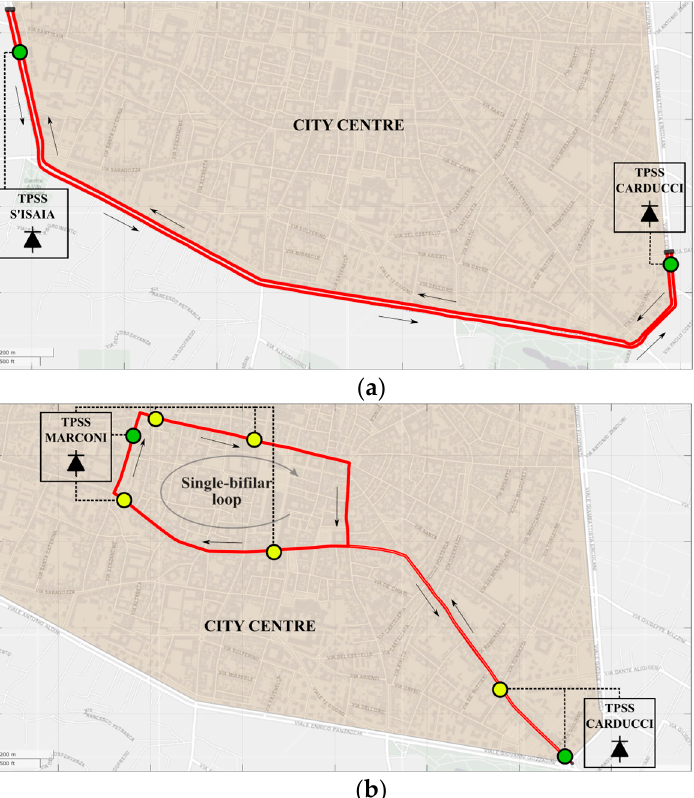
Figure 7. Bologna’s FSs selected for the case study. The trolleybus routes (oriented by arrows) of the FS “S’Isaia-Carducci” ( a ) and FS “Marconi-Carducci” ( b ) are plotted together with TPSSs and supply points (connection points of line feeders with the OCL in green and of reinforcing feeders in yellow).